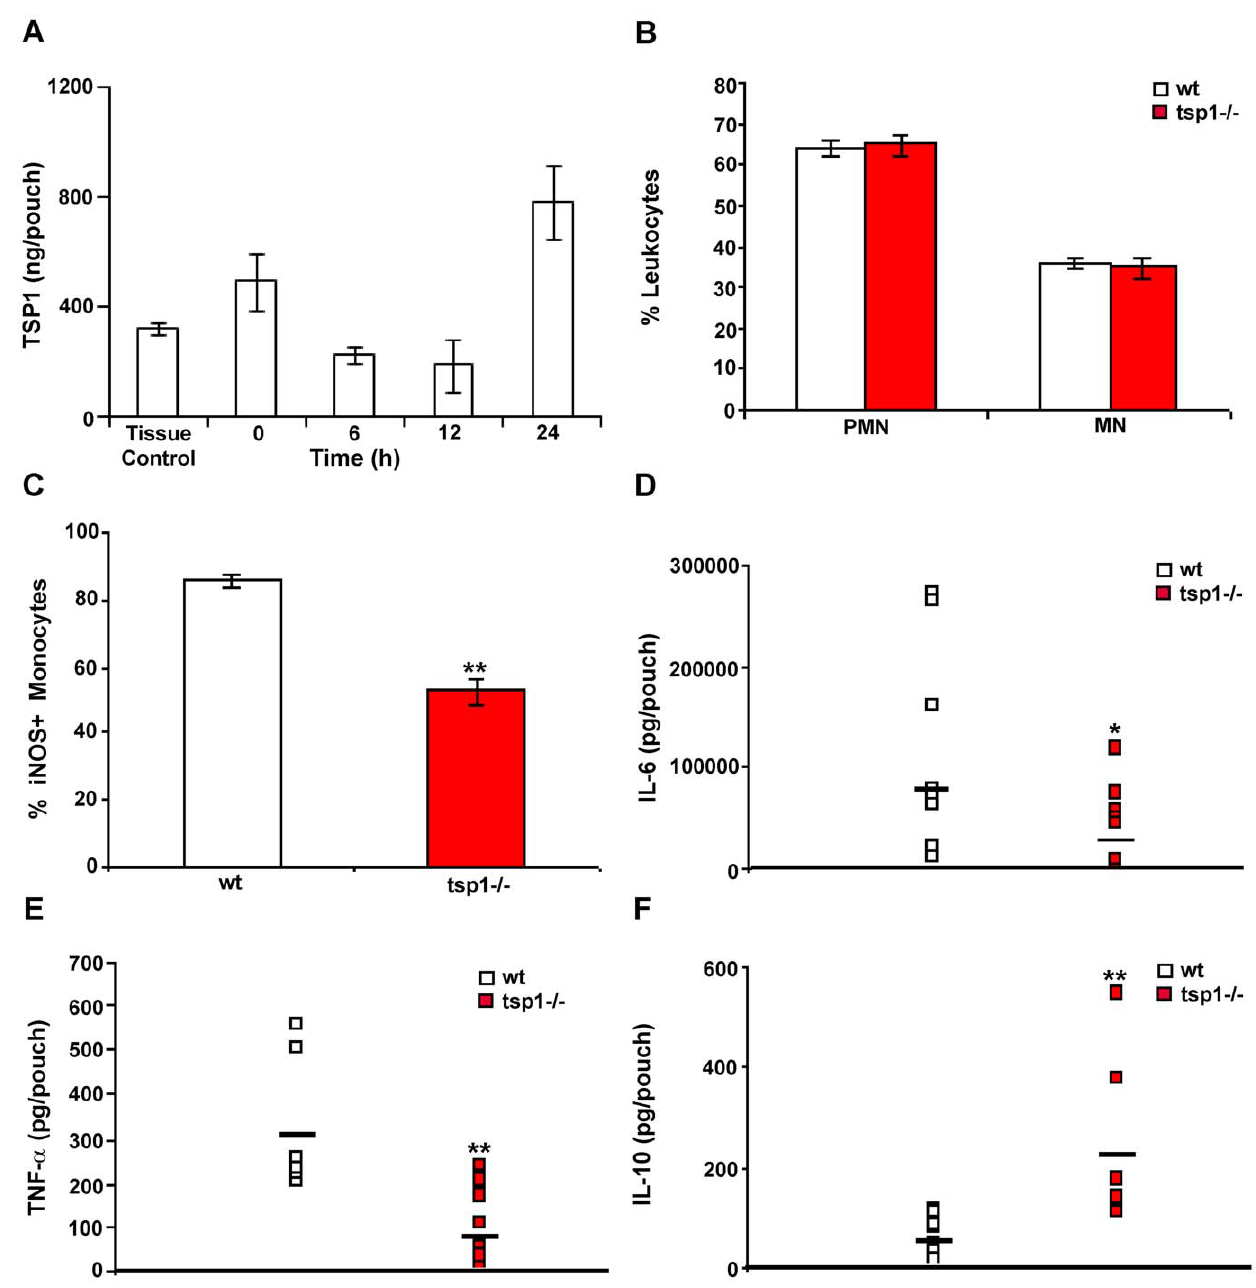
Figure 2. TSP1 enhances inflammation-mediated activation of macrophages invivo . (A–F) Six day-old air pouches received 1 ml of 1% l - carrageenan. (A) Mice were sacrificed at the indicated time points before (time 0 h) or after l -carrageenan injection. For the tissue control, mice without air pouches were subcutaneously injected in the back with 1 ml of saline and the lavage fluid was collected. The levels of mouse TSP1 in the air pouch exudates were determined by immunoassay. Data are pooled from two independent experiments. Bars, mean 6 SD, n=4 wt mice/group. One-way ANOVA (p=0.0097). (B–F) wt and tsp1 2 / 2 mice were sacrificed 6 h after injection of 1% l -carrageenan. Quantitative analysis of leukocyte infiltration was performed by a pathologist evaluating the percentage of PMN and MN (B) and iNOS + monocytes (C) in 10 different 400 6 fields with inflammatory infiltrate. Bars, mean 6 SEM, n=8 2 10 mice/group. (D–F) IL-6, TNF- a , and IL-10 were determined in the air pouch lavage using a multiplexed ELISA array. Data represent geometric mean, n=8 2 10 mice/group. *indicates p , 0.05; **indicates p ,